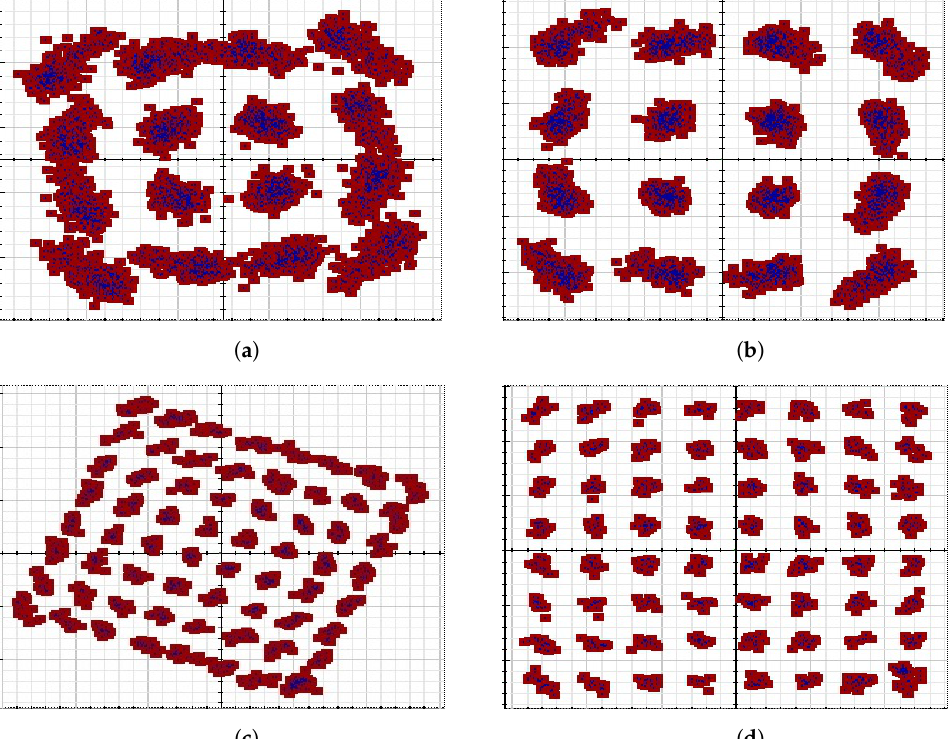
Figure 10. Constellation visualizer diagrams; ( a ) constellation diagram of 16QAM-OFDM at 10 km distance and 5 GHz RF without addressing NLs, LDs and phase noise, ( b ) constellation diagram of 16QAM-OFDM at 10 km distance and 5 GHz RF after the proposed DSP receiver, ( c ) constellation diagram of 64QAM-OFDM at 10 km distance and 5 GHz RF without addressing NLs, LDs and phase noise and ( d ) constellation diagram of 64QAM-OFDM at 10 km distance and 5 GHz RF after the proposed DSP receiver.